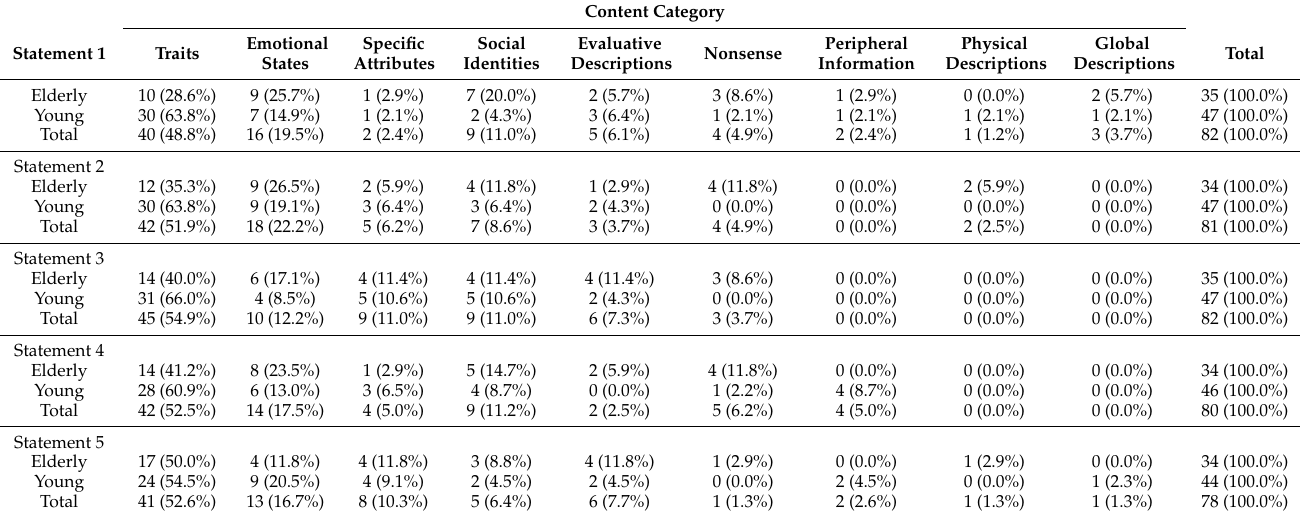
Table 4. Crosstabulation of age group by content category for each statement of the TST. Content